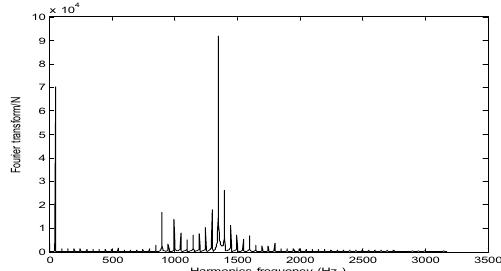
Fig. 5(b). Results of frequency characteristics of the filtered signal in the high frequency range